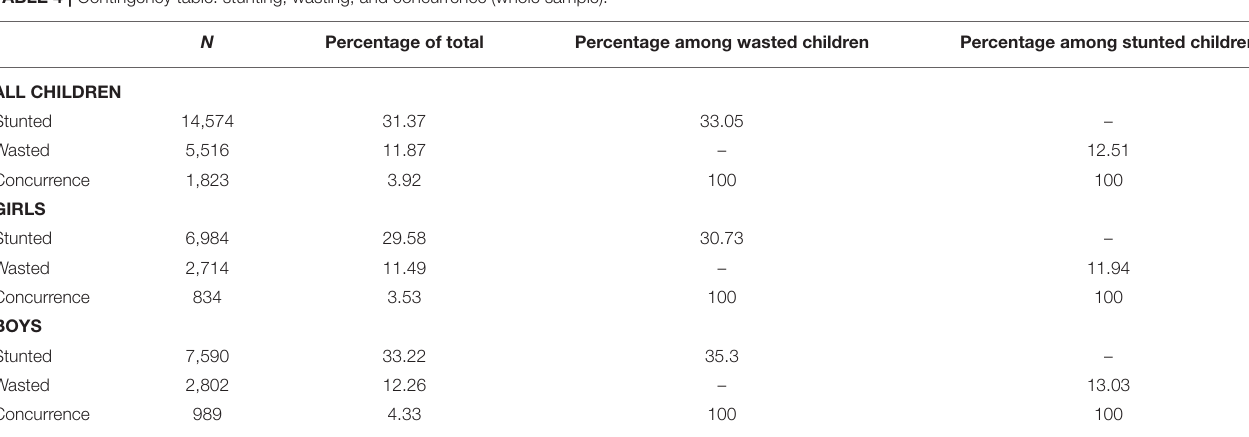
TABLE 4 | Contingency table: stunting, wasting, and concurrence (whole sample). N Percentage of total Percentage among wasted children Percentage among stunted